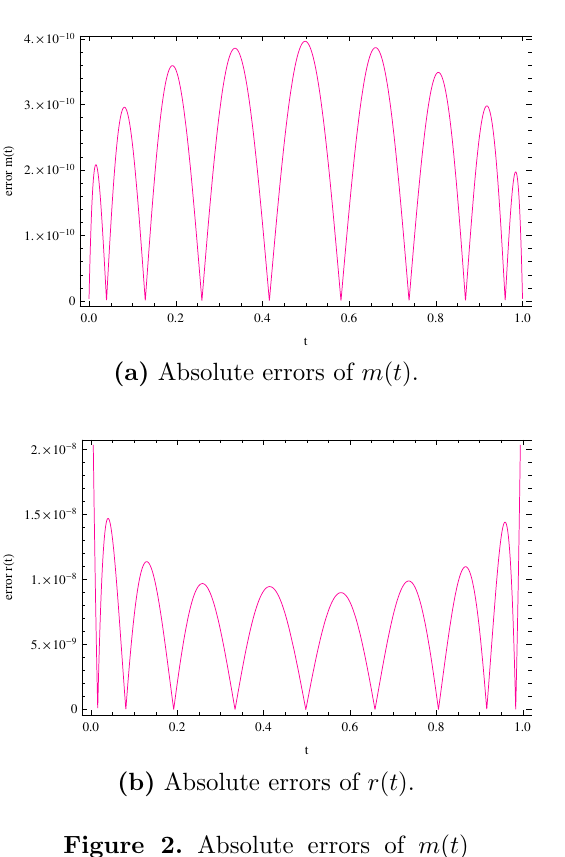
Comparison of (46) with our approximate solu- Table 4 demonstrate the behaviour of absolute errors for Example 2 under different conditions.